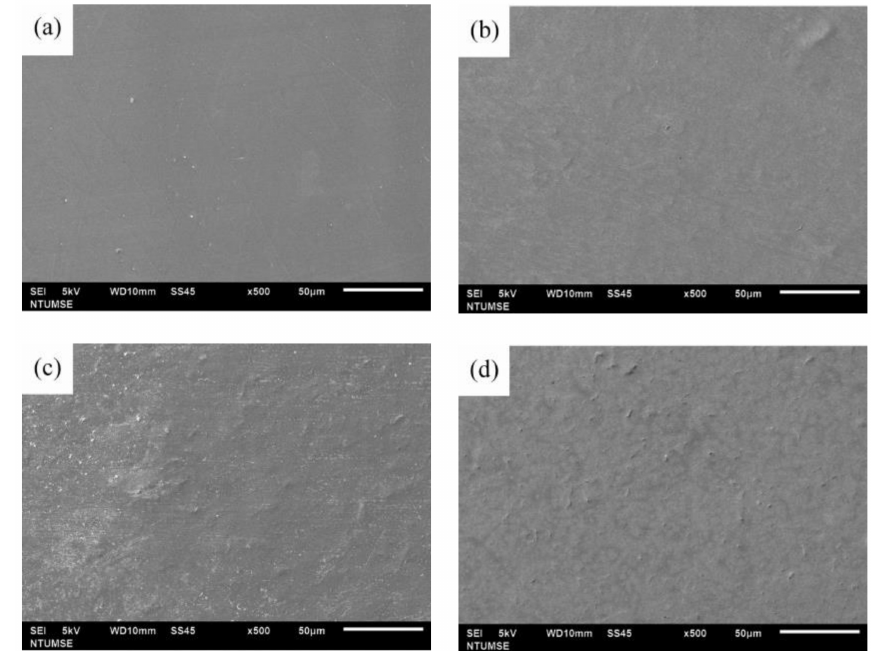
Figure 1. Scanning electron microscopy (SEM) images of coating samples: ( a ) Polyurethane (PU), ( b ) PU2, ( c ) PU4 and ( d )